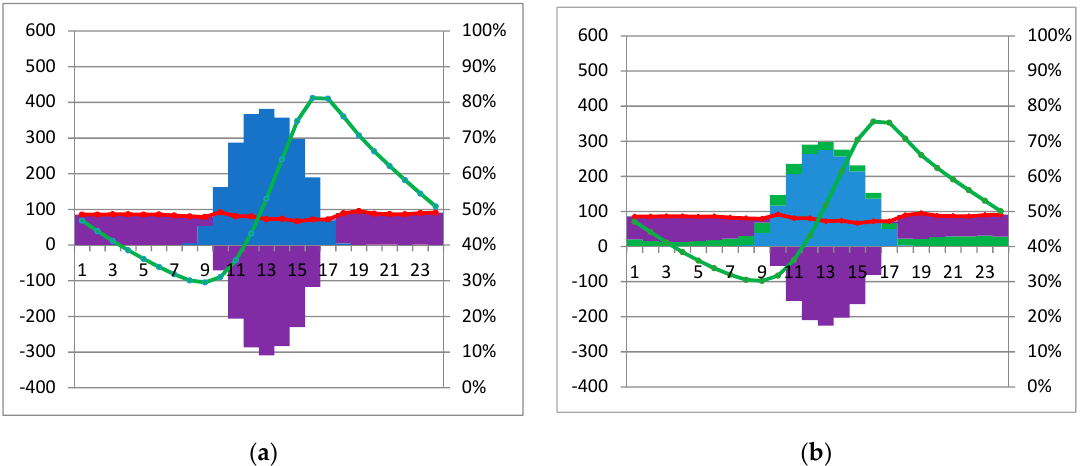
Energies 2019 , 11 , x FOR PEER REVIEW Figure 6. Day 2, 03/01/2009: Energy balance ( a ) without and ( b ) with tidal energy.